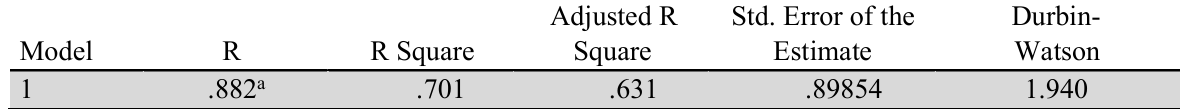
Adjusted R Std. Error of the Durbin- Square Estimate Watson